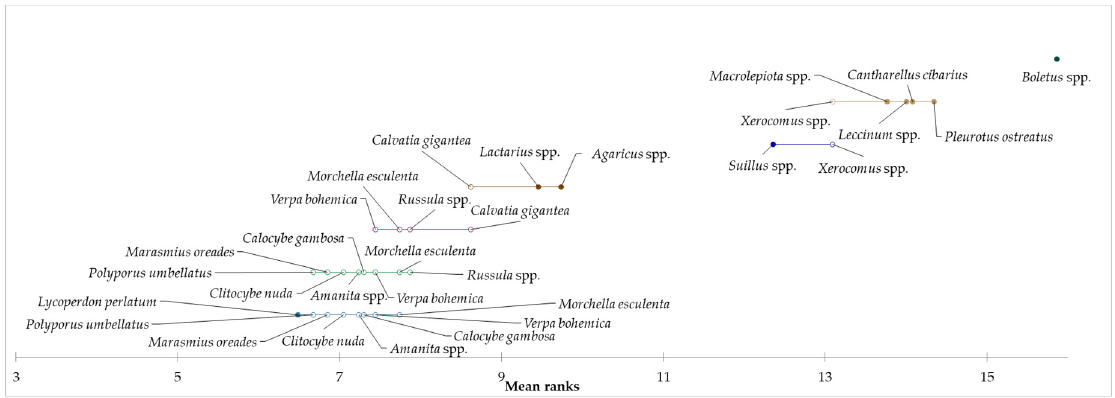
Figure 1. Differences in the evaluation of preferred species of mushrooms in the “occasional con- sumers” segment.